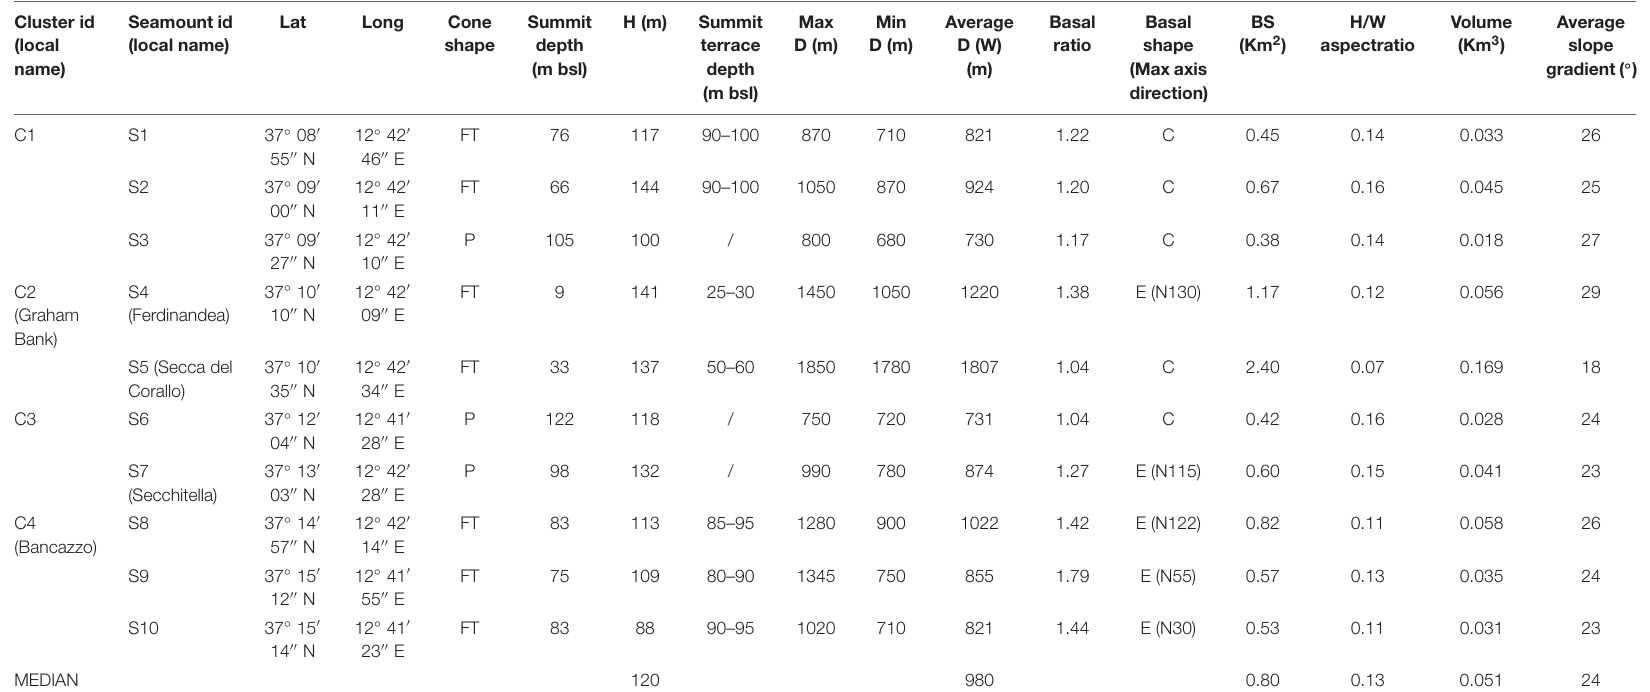
TABLE 1 | Main morphological dimensions and morphometric associated parameters of the cones of the GVF. Cluster id